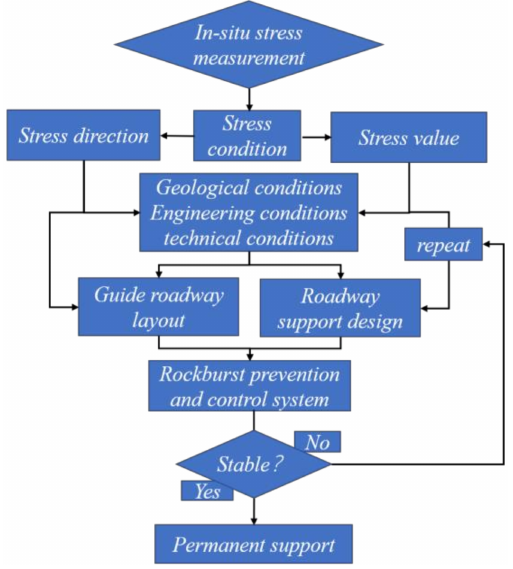
Figure 10. Algorithm flow chart.